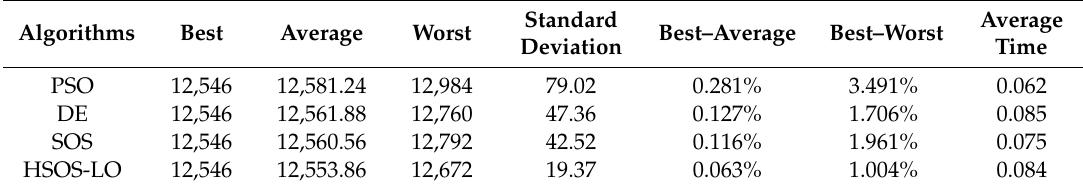
Table 3. Travel distance between